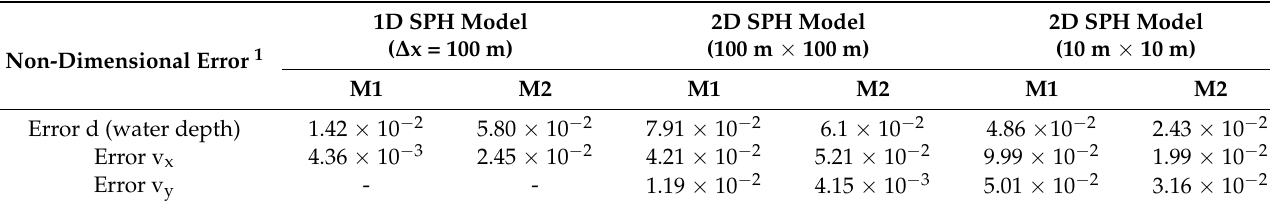
Figure 8. Results of 2D simulation for M2 curve longitudinal profile: ( a ) velocity and ( b ) water level. Table 5. Maximum reported